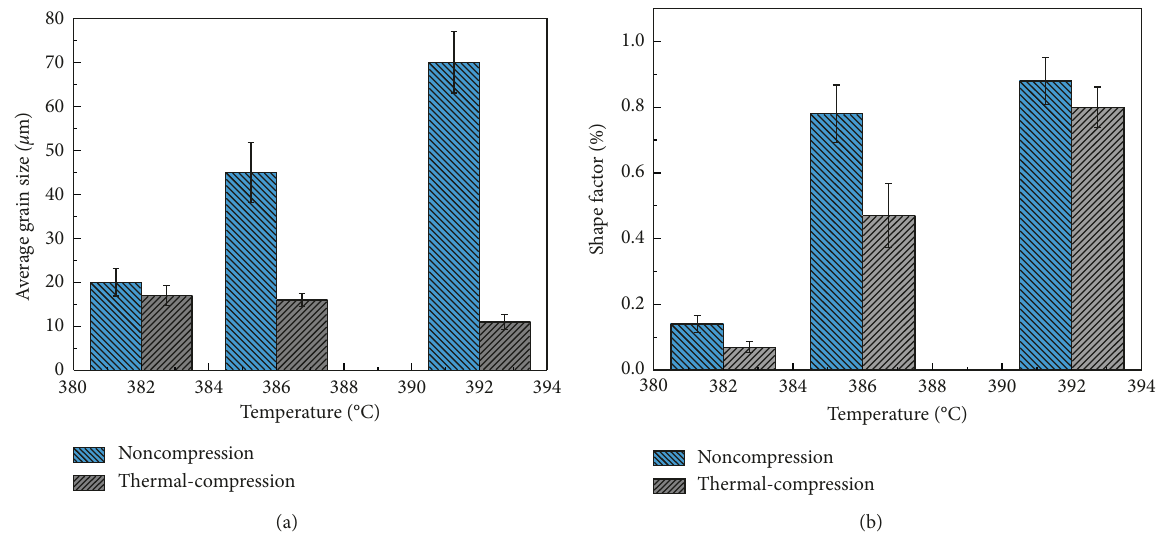
Figure 8: The variation of grain size and shape factor of the η -Zn phase with different